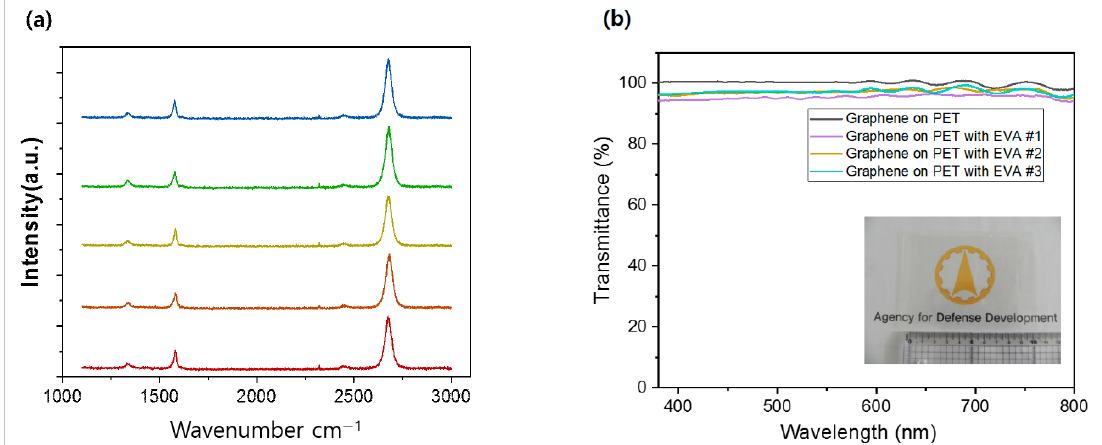
Figure 3. ( a ) Raman spectra of graphene transferred on a SiO 2 /Si wafer by the established PMMA assisted wet transfer method, ( b ) UV-Vis spectra of graphene transferred on EVA(Ethylene − vinyl acetate) with PET.